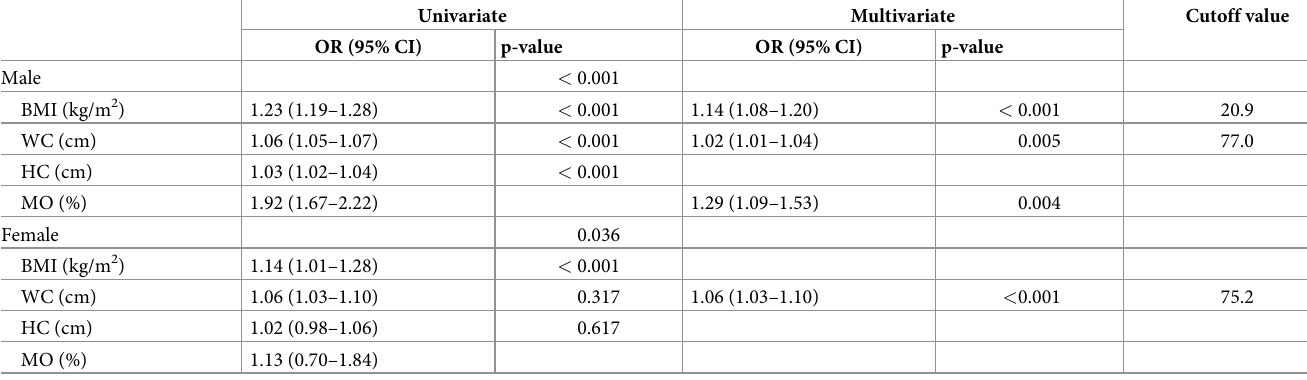
Table 5. Relationship of hypertension to body mass index, waist circumference, hip circumference, and masked